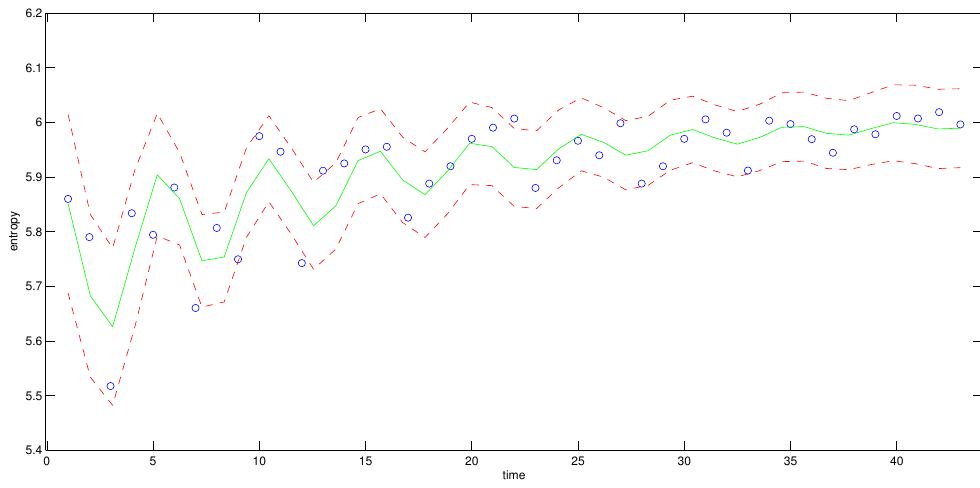
Figure 6: Plot of the original data (the circular points), improved model (the con- nected curve), and 95 % confidence band of the regression (the region between the dashed